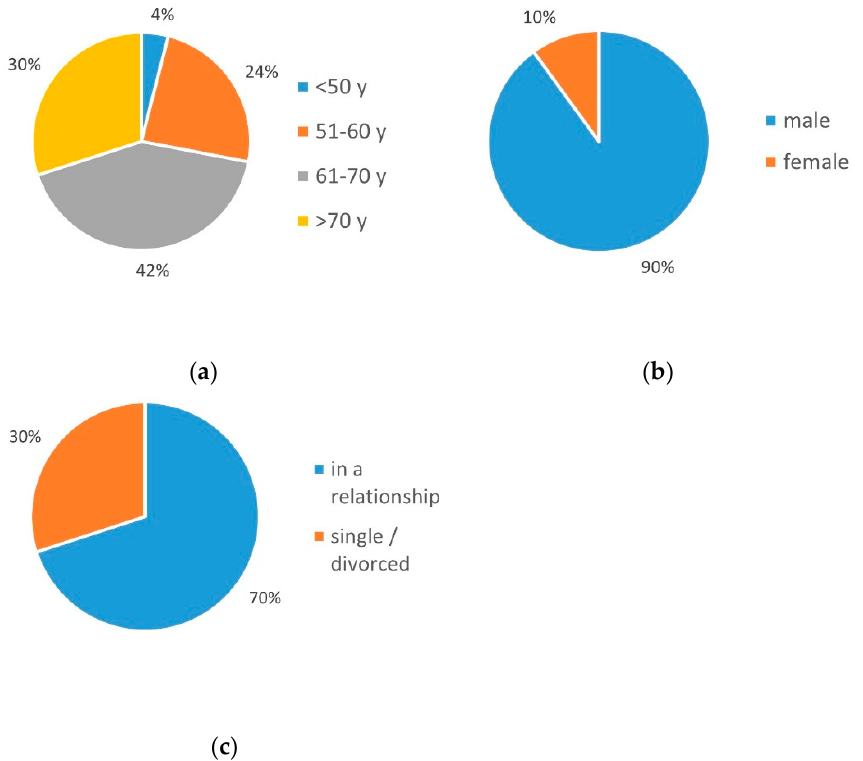
( b ) Figure 2 . Health status: ( a ) current condition (self-assessment), ( b ) 6-minute-walk-distance . It turned out that 78% ( n = 39) of the VAD patients were able to access support at home (Figure 3b). In 66% ( n = 33) of the cases, family members and/or friends were the supporters, 24% ( n = 12) had professional help, and in 10% ( n = 5) of the cases, patients were either on their own or dependent on sporadic supporters (Figure 3c) (Multiple an- swers were possible in answering this question.) The questionnaire revealed that most patients with a VAD system were no longer able to pursue regular employment—96% ( n = 48) of the patients were without perma- nent employment and receiving pension or social welfare benefits (Figure 3a).